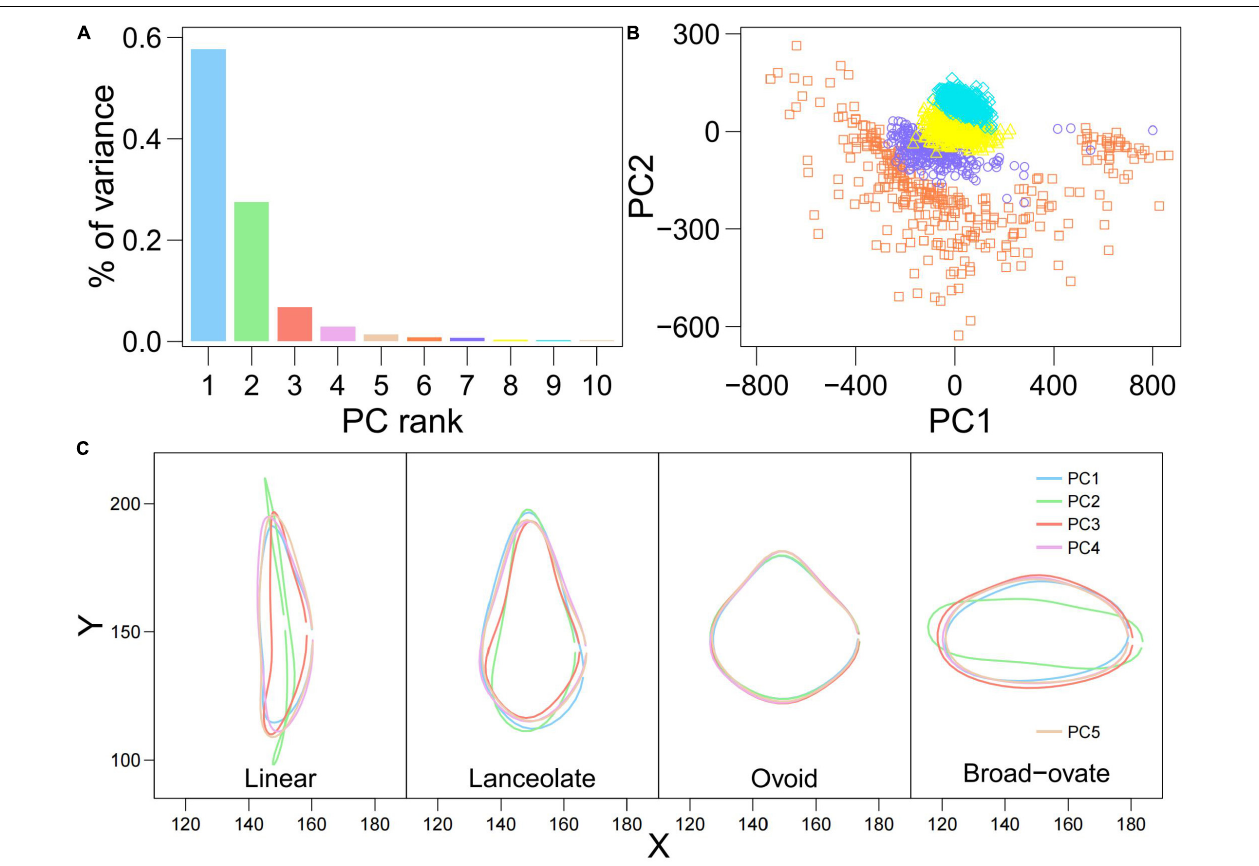
FIGURE 3 | Principal component analysis (PCA) analysis calculated from the landmark data of 860 genotypes for heterophylly. (A) The barplot of PC contributions. (B) Biplot of the first and second principal components. The square, circle, triangle, and diamond symbols represent the linear, lanceolate, ovoid, and broad-ovate leaves, respectively. (C) The mean shape of four heterophyllous leaves on the first five PCs.